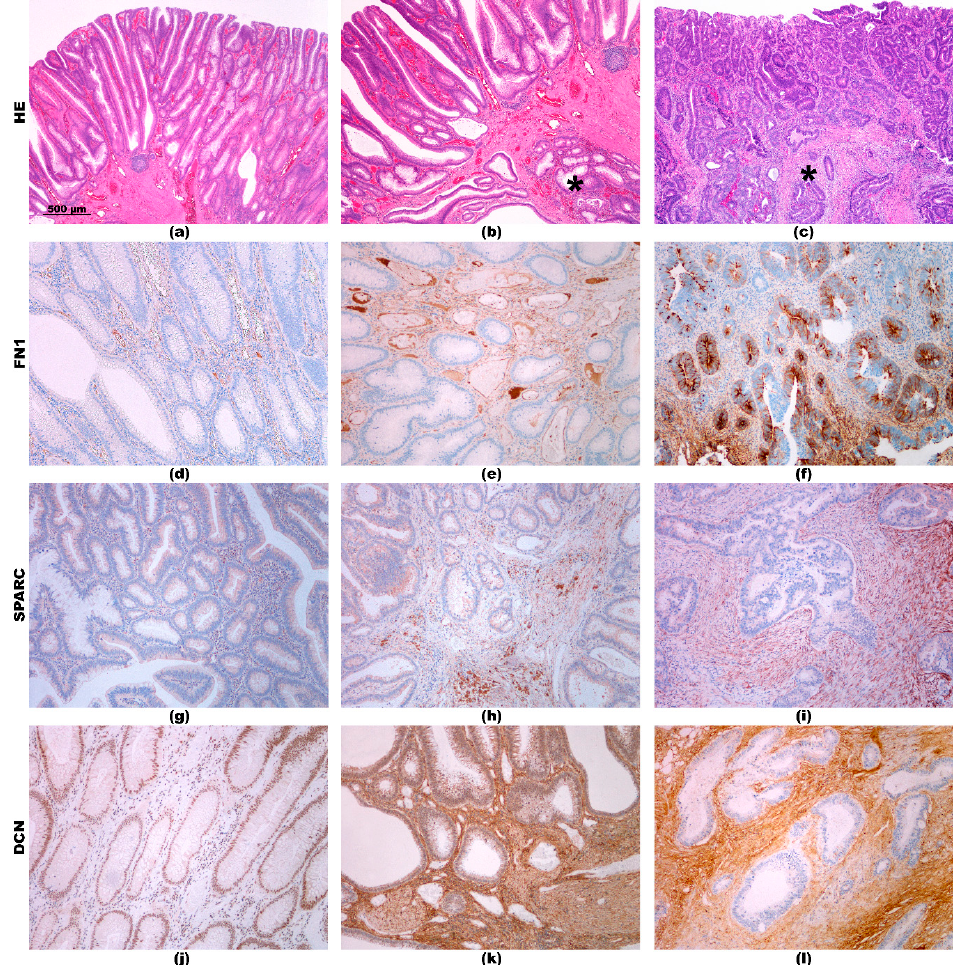
Figure 2. ( a ) Adenoma; ( b ) adenoma with epithelial misplacement—epithelial misplacement in the submucosa is marked by asterix *; ( c ) adenoma with early carcinoma; invasive carcinoma in the submucosa is marked by asterix *. HE staining, orig. magnification 4×. FN 1: Mild positive reaction in